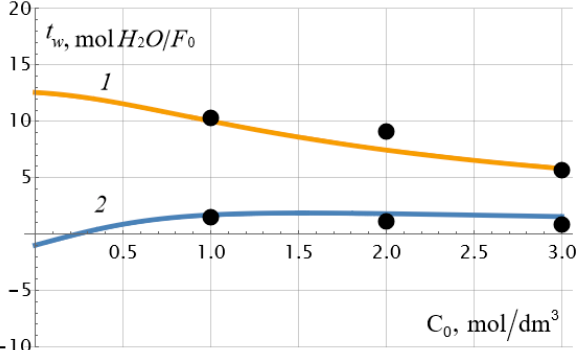
Figure 5. Experimental (symbols) and theoretical values of the electroosmotic (curve 1 ) and osmotic (curve 2 ) numbers of water transport through the MF − 4SC p.29 membrane depending on the equilibrium concentration of an aqueous solution of NaCl in the case of counter-directional electroosmotic and osmotic water fluxes.